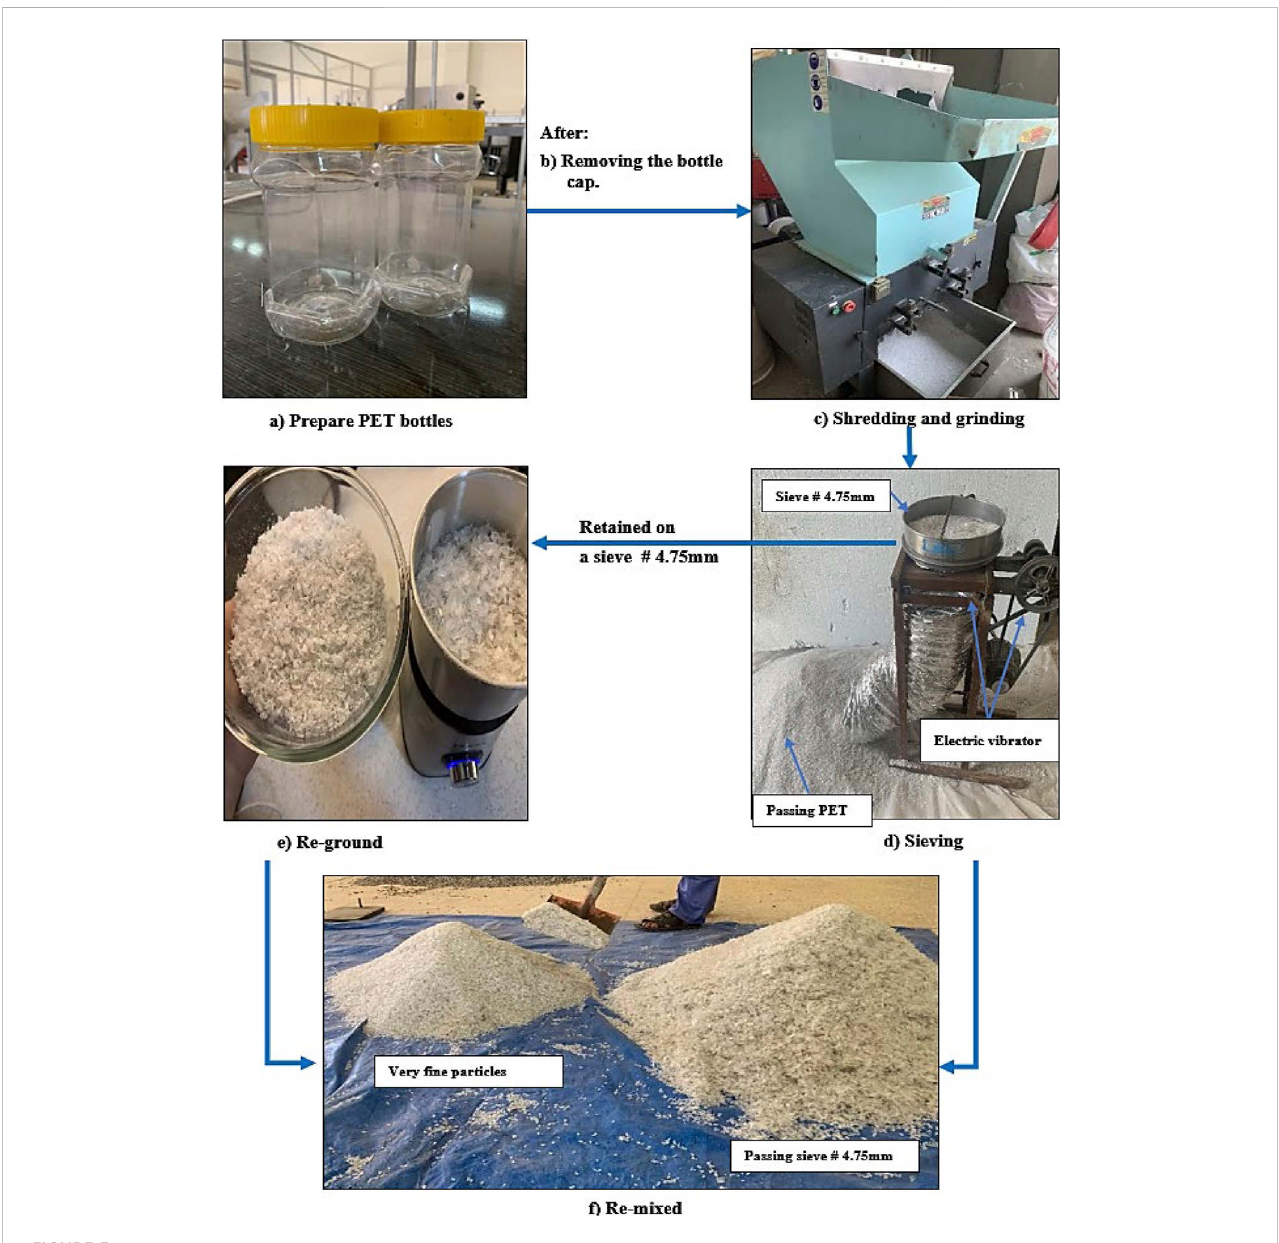
Processing of PET